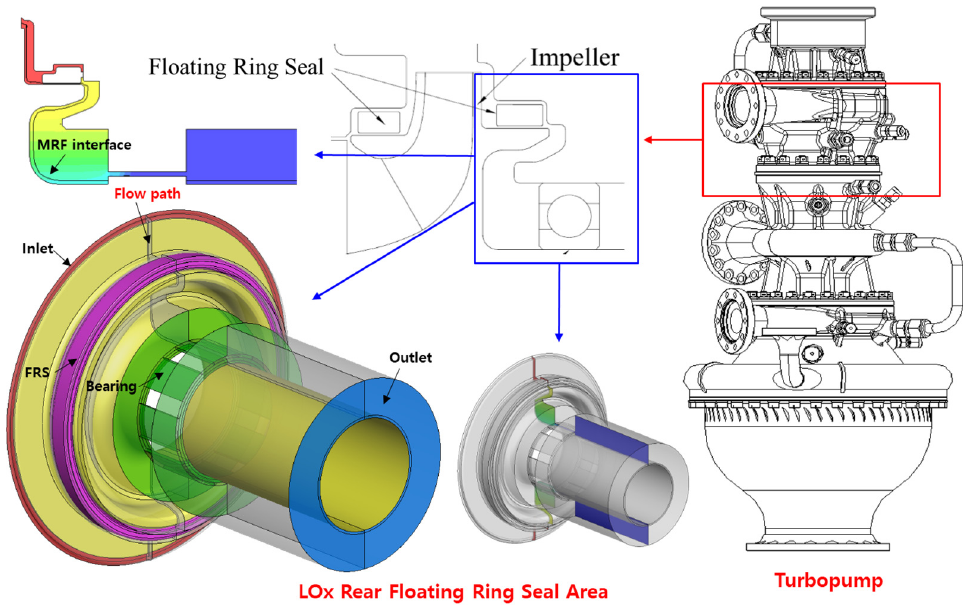
Figure 4. Schematics of LOx rear floating ring and bearing cooling flow path.